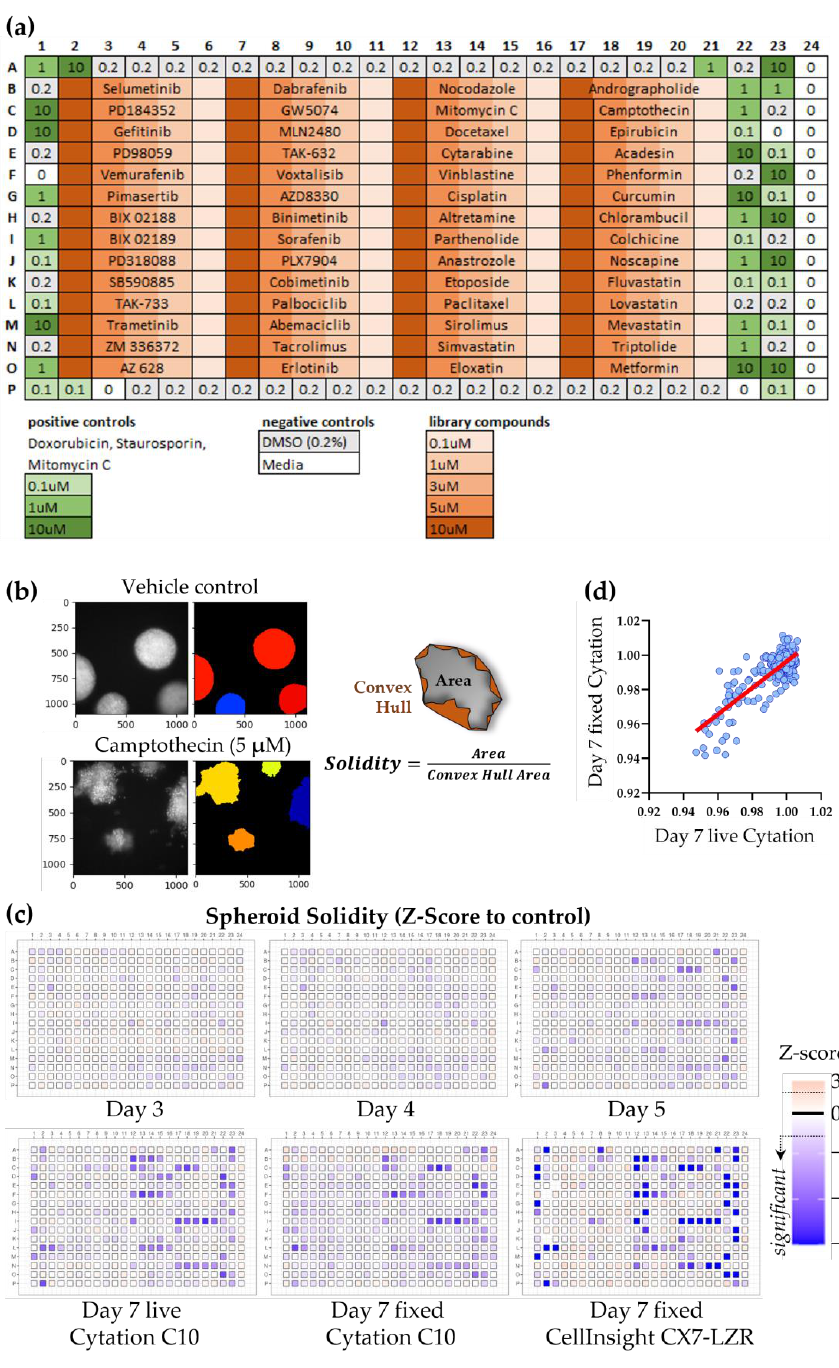
Figure 5. ( a ) Compound library plate (384 well plate coordinates from columns 1-24 and rows A-P) layout indicating location and concentration of vehicle and negative controls (0.2% DMSO, media), positive controls, and library drugs. ( b ) Visual representation and mathematical equation of Solidity, a frequently used spheroid shape descriptor. ( c ) Spheroid Solidity plotted as a heatmap before drug treatment (day 3 after seeding), at the day of treatment (day 4), 1 day post-treatment (day 5), and 3 days post-treatment (day 7), captured live (Cytation C10) and fixed/quenched and stained (Cytation C10 and CellInsight CX7 LZR platform). The colour indicates Z-scores compared to vehicle controls per time-point. Z-scores below − 2 and above +2 correspond to a significant change compared to control (dashed lines). ( d ) Pearson correlation of day 7 live versus fixed well average Area Solidity feature (R 2 =